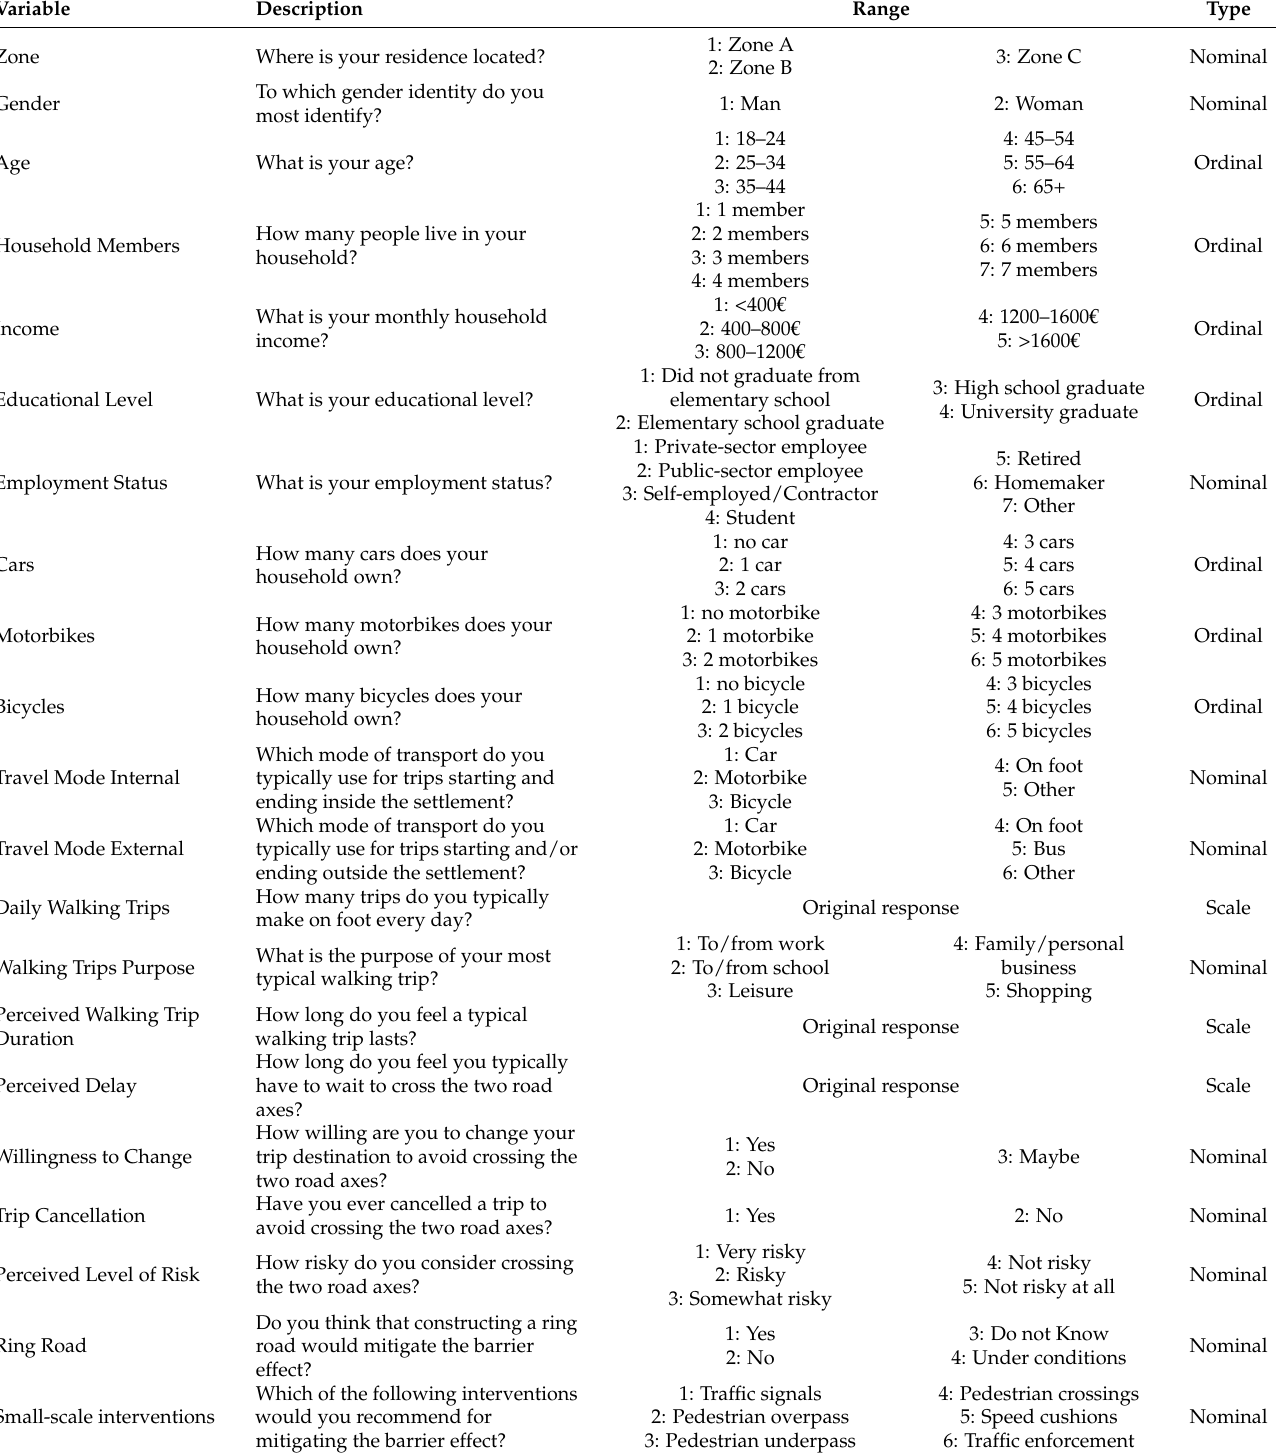
Table 1. Overview of the variables